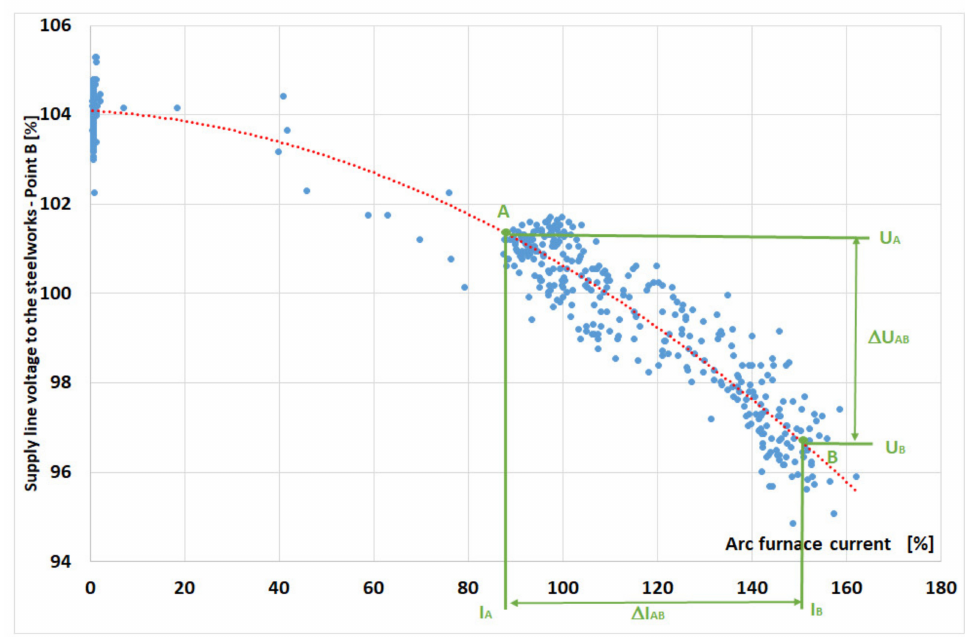
Figure 5. Voltage changes as a function of furnace current changes. For the single-phase power supply scheme for the arc furnace shown in Figure 4 and the current changes with the assumed values of I A and I B , a vector diagram can be drawn—Figure 6.